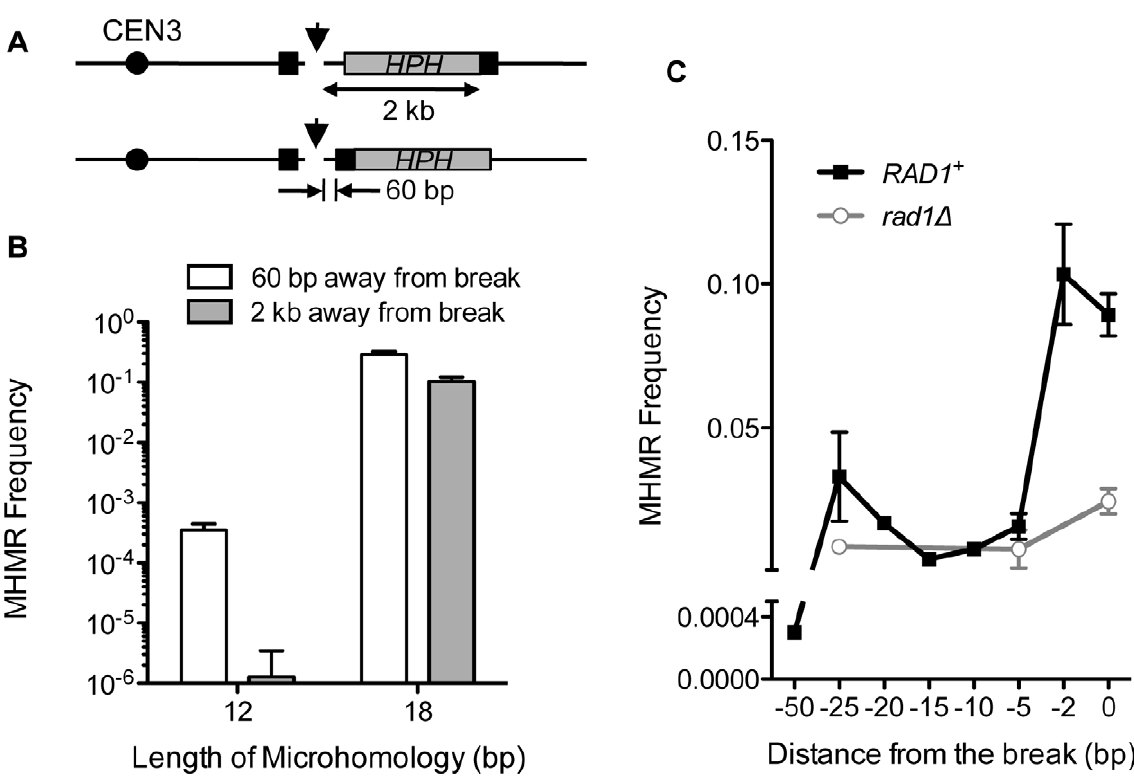
Figure 2. The distance from the DSB inversely affects MHMR frequency. (A) A diagram showing strains with microhomology inserted 2 kb and 60 bp from the DSB. HPH (gray box) represents the hygromycin B phosphotransferase gene. The position of the microhomology (black box) and the distance to the HO cleavage site are shown. (B) Survival using the microhomology for strains with 12 or 18 bp of microhomology located at 60 bp or 2 kb from the DSB. Survival frequency was calculated as shown in Figure 1B. For MHMR using microhomology at 60 bp from the DSB, the repair events were distinguished by sequencing of the repair junctions. The results are the average of three independent experiments 6 S.D. (C) MHMR frequency using the 18 bp microhomology at various locations from the DSB in wild type and rad1 D . Survival frequency was calculated as shown in Figure 1B. The results are the average of three independent experiments 6 S.D.